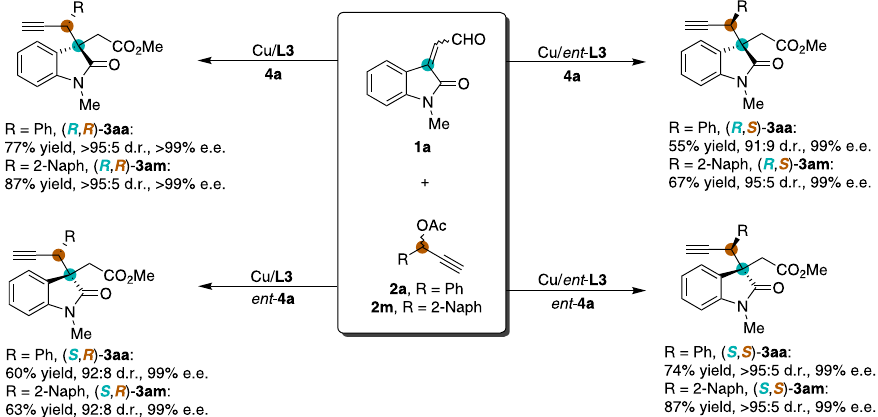
Fig. 5 Stereodivergent synthesis of all four stereoisomers of oxindoles 3aa and 3am via cooperative NHC/Cu catalysis. Reaction conditions: Cu(CH 3 CN) 4 PF 6 (5 mol%) and pyridine bis(oxazoline) ligand L3 or ent -L3 (10 mol%) were stirred in THF (0.5 mL) at 25 °C for 1 h, then NHC precatalyst 4a or ent -4a (5 mol%), 1a (0.15 mmol), 2 (0.1 mmol), MeOH (0.5 mmol), Na 2 CO 3 (0.1 mmol) and THF (0.5 mL) were added to the reaction mixture and stirred for 12 h under N 2 . Diastereomeric ratio (d.r.) was determined by 1 H NMR spectroscopic analysis. Isolated yields. The enantiomeric excess (e.e.) was determined by